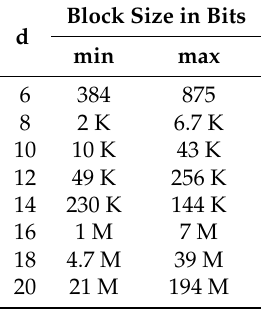
Table 4. The minimum ( d · 2 d ) and maximum ( d · 2 d · ( d − 1.44 to the proposed non-UD coding scheme for selected d